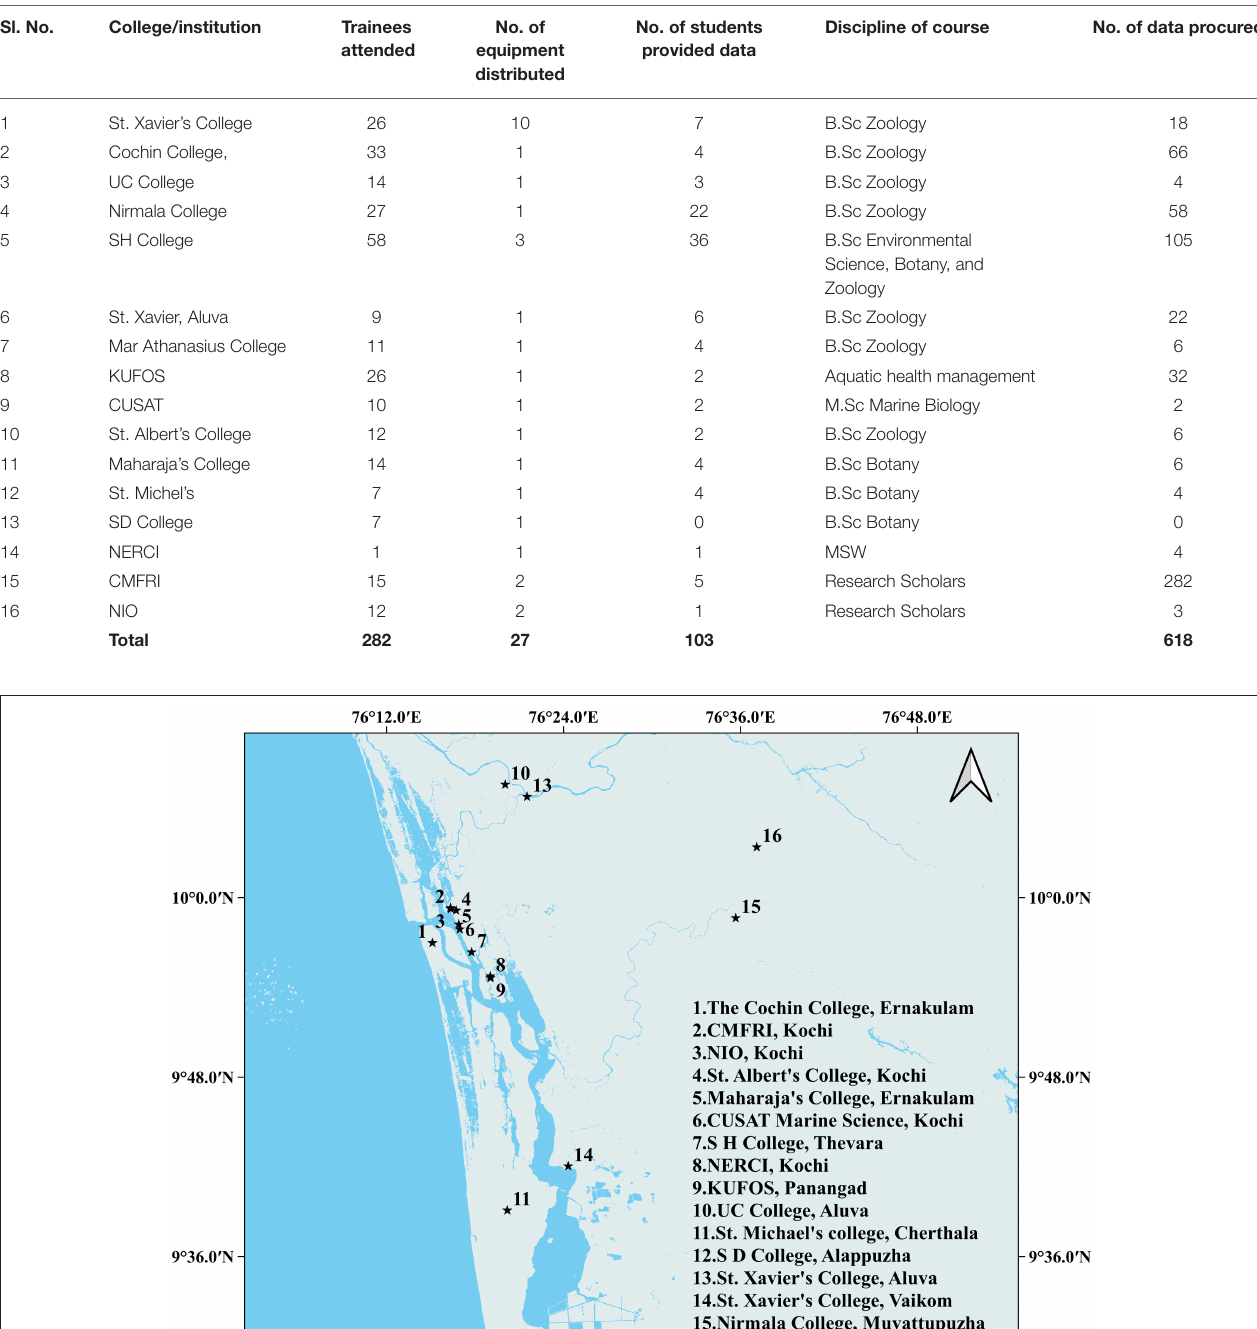
an oral feedback survey was conducted among the citizens who provided data using “TurbAqua” app to assess the good-will generated. The results show that 46% of the participants rated